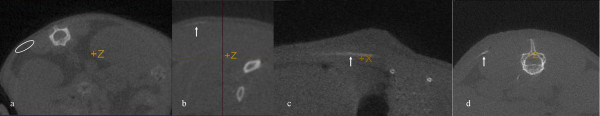
Micro-CT images of the experimental mice. The mice were injected subcutaneously with 10 μL {(Au0)200-G5.NH2} DENPs at [Au] of 0.007 (a), 0.009 (b), 0.01 (c), and 0.02 M (d). The white circle in (a) indicates the injection site. Arrows in the remaining panels show where Au DENPs have become distributed as a short segment in the interspace between the skin and the subcutaneous soft tissue. The mean CT values at the injection region were 31.57 (a), 41.23 (b), 48.56 (c), and 75.76 HU (d).